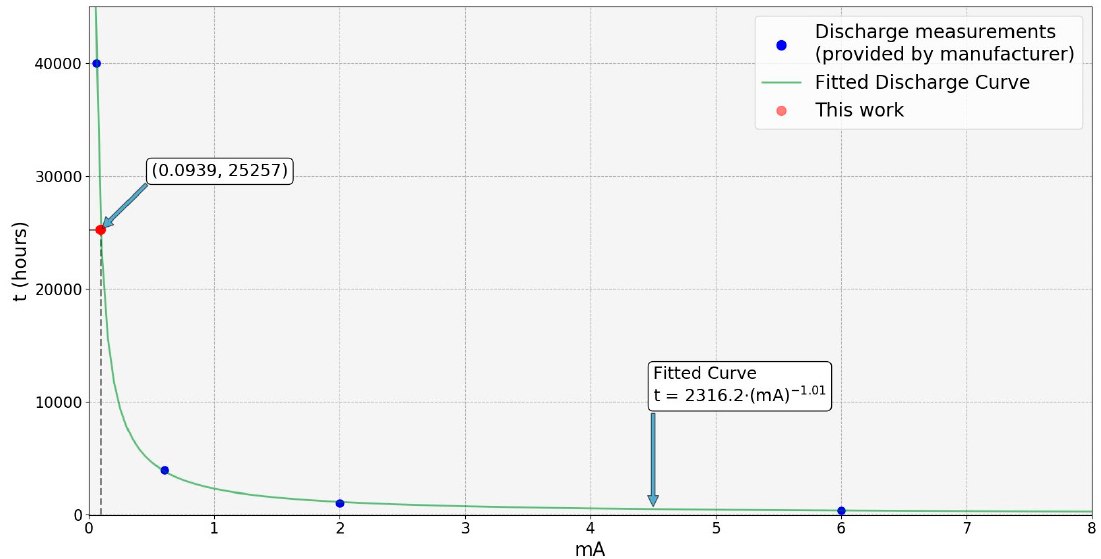
Figure 16. Fitted curve for battery life versus current consumption. Blue points highlight values obtained from the discharge curves provided by the manufacturer. The red point highlight the value corresponding to this work.